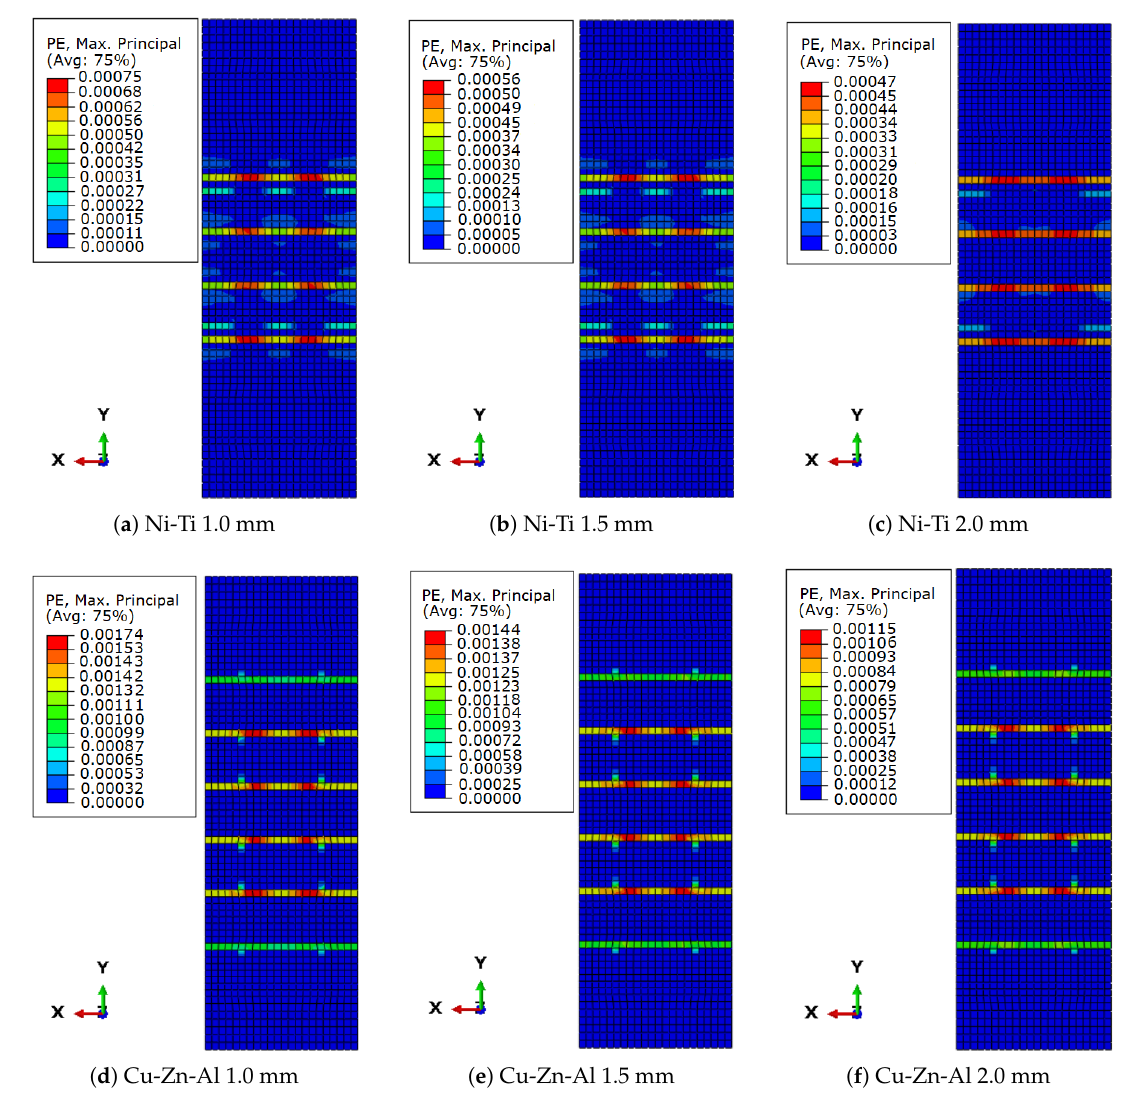
Figure 16. Plastic residual strain in retrofitted models: ( a ) 1.0 mm Ni-Ti; ( b ) 1.5 mm Ni-Ti; ( c ) 2.0 mm Ni-Ti; ( d ) 1.0 mm Cu-Zn-Al; ( e ) 1.5 mm Cu-Zn-Al; ( f ) 2.0 mm